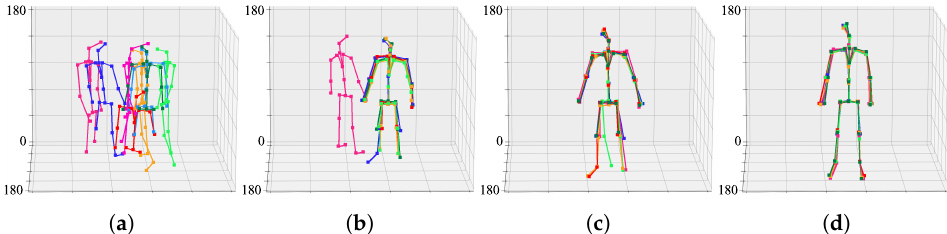
Figure 11. Progress of calibration and 3D joint set estimation according to frame. Each raw corre- sponds to a view-point of a 3D model. ( a ) initial joint sets, ( b ) joint sets in the 15th frame, ( c ) joint sets in the 21st frame, ( d ) joint sets in the 30th